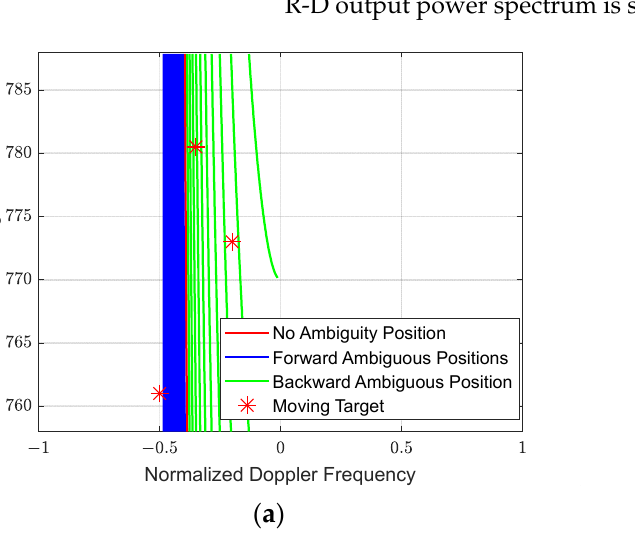
Figure 6. Range-Doppler output power spectrum: ( a )Theoretical spectrum of received clutter and moving target; ( b ) Simulation spectrum with moving target.